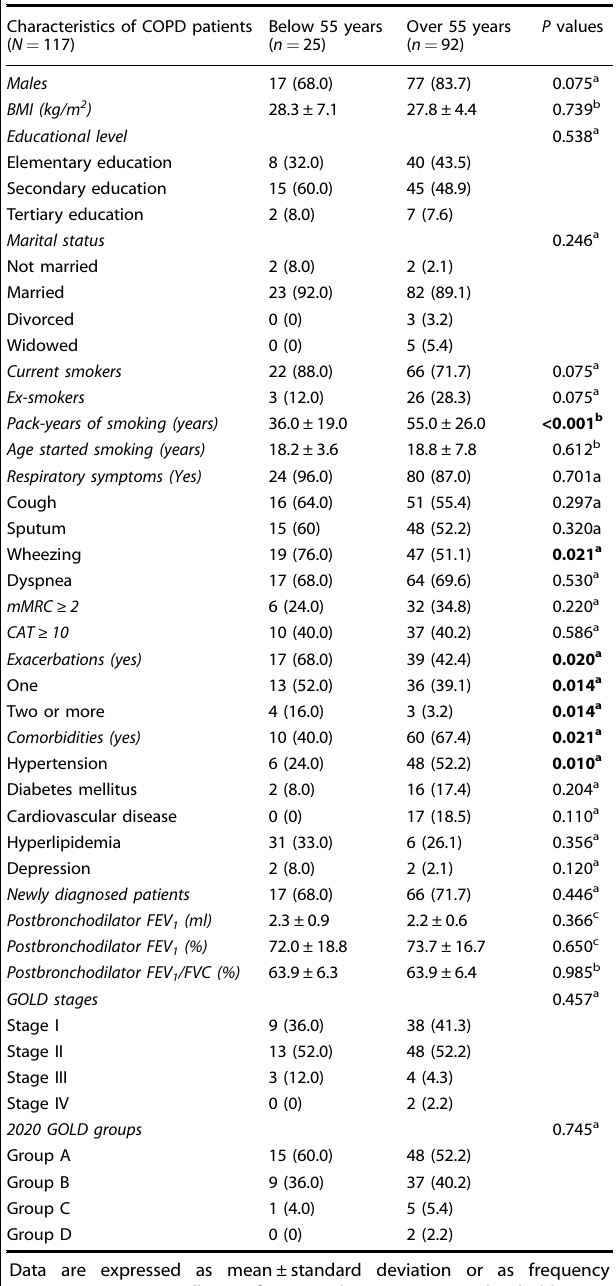
Table 2. Comparisons of demographic, clinical, and spirometric characteristics between COPD patients over and below 55 years of